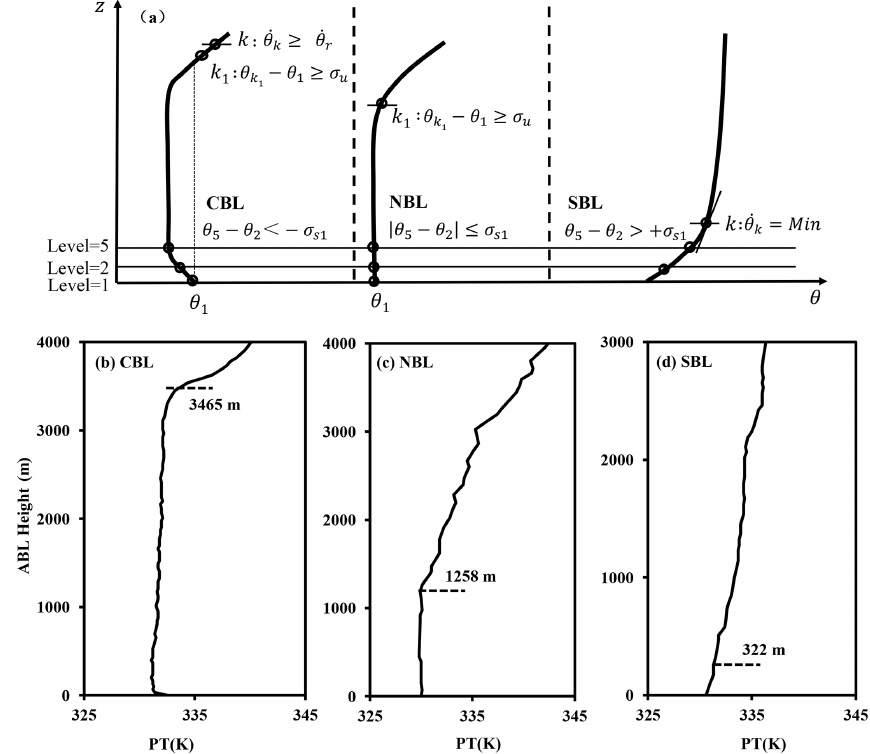
Figure 2. (a) Illustration of the determination procedure for the convective boundary layer (CBL), neutral boundary layer (NBL), and stable boundary layer (SBL) heights and examples of the potential-temperature (PT) profiles derived from sounding observation at Lasa station at 20:00BJT for (b) CBL on 10 June 2013, (c) NBL on 21 July 2013, and (d) SBL on 11 August 2013, respectively. The dashed line in (b–d) represents the ABL height identified using the algorithm